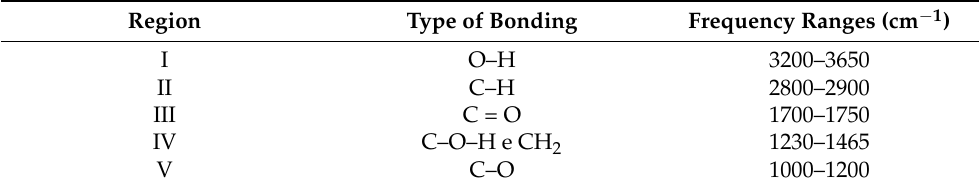
Table 7. A list of the five regions highlighted in the spectrum illustrated in Figure 7 corresponds to some types of bonding interactions at specific IV–TF frequencies (cm − 1 ).